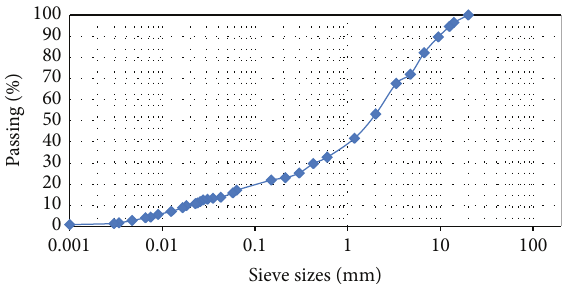
Figure 1: Particle size distribution of subgrade soil.